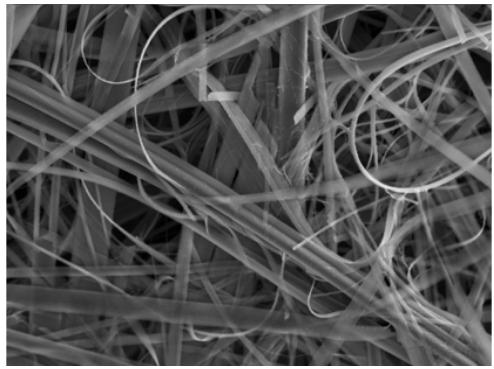
] at P = 7 . 7 kbar, 2 2